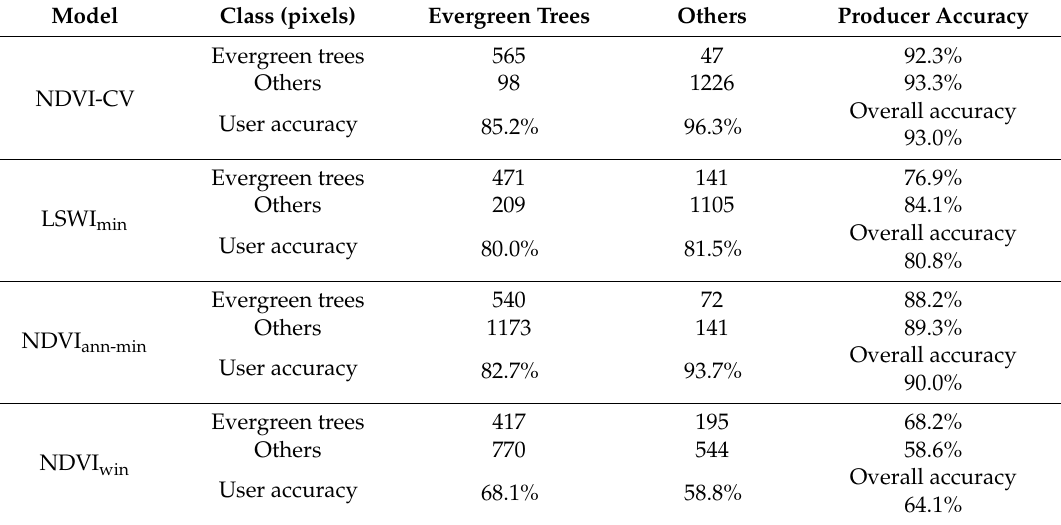
Table 5. Comparison of high-resolution image verification accuracy. LSWI: land surface water index.